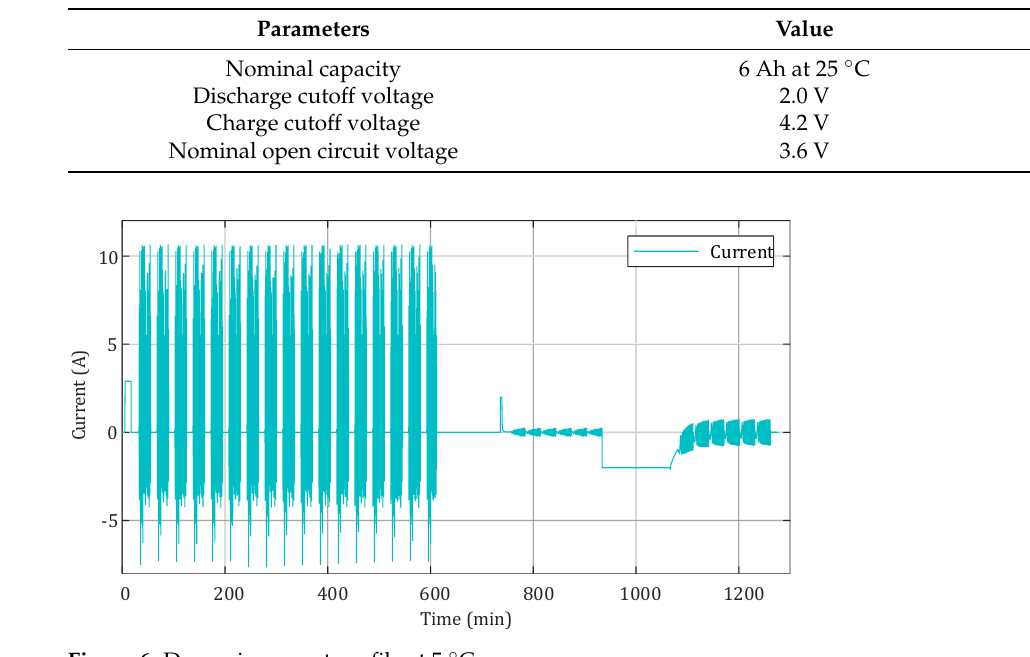
Figure 6. Dynamic current profile at 5 ◦